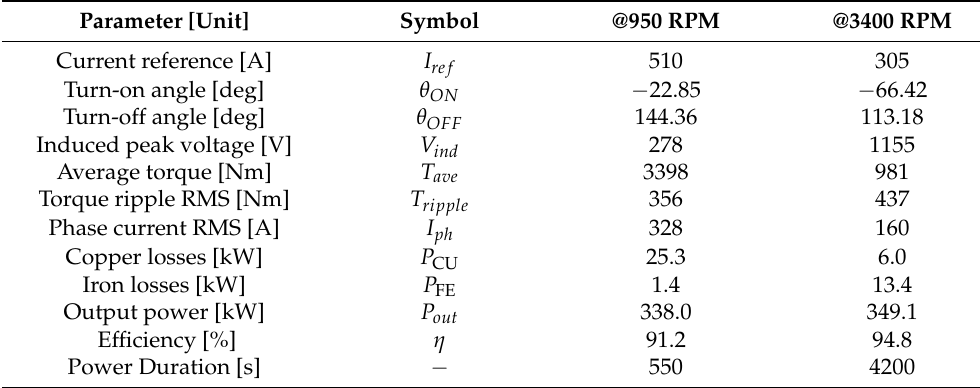
Figure 8. Dynamic results for the 36/24 SRM at ( a ) 950 RPM and ( b ) 3400 RPM. From top to bottom: phase currents, torque, and phase and induced voltages. Table 7. 36/24 SRM performance